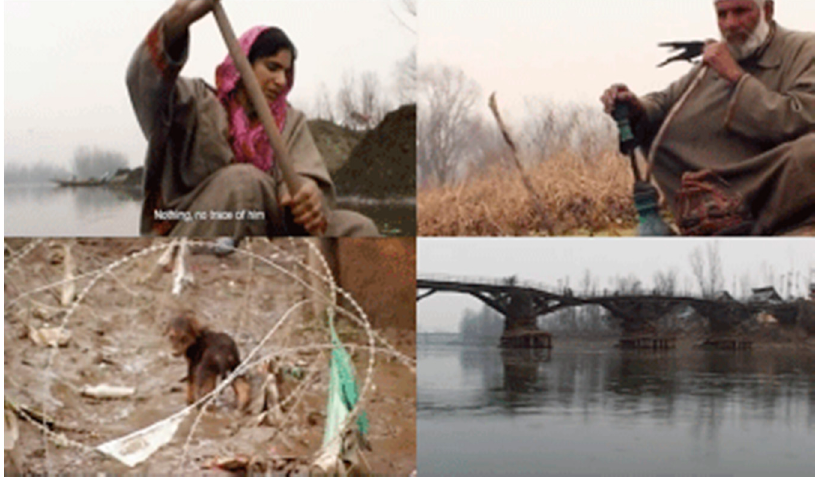
Figure 1. Khoon Diy Baarav (2015), beginning sequence, by courtesy of Iffat Fatima.